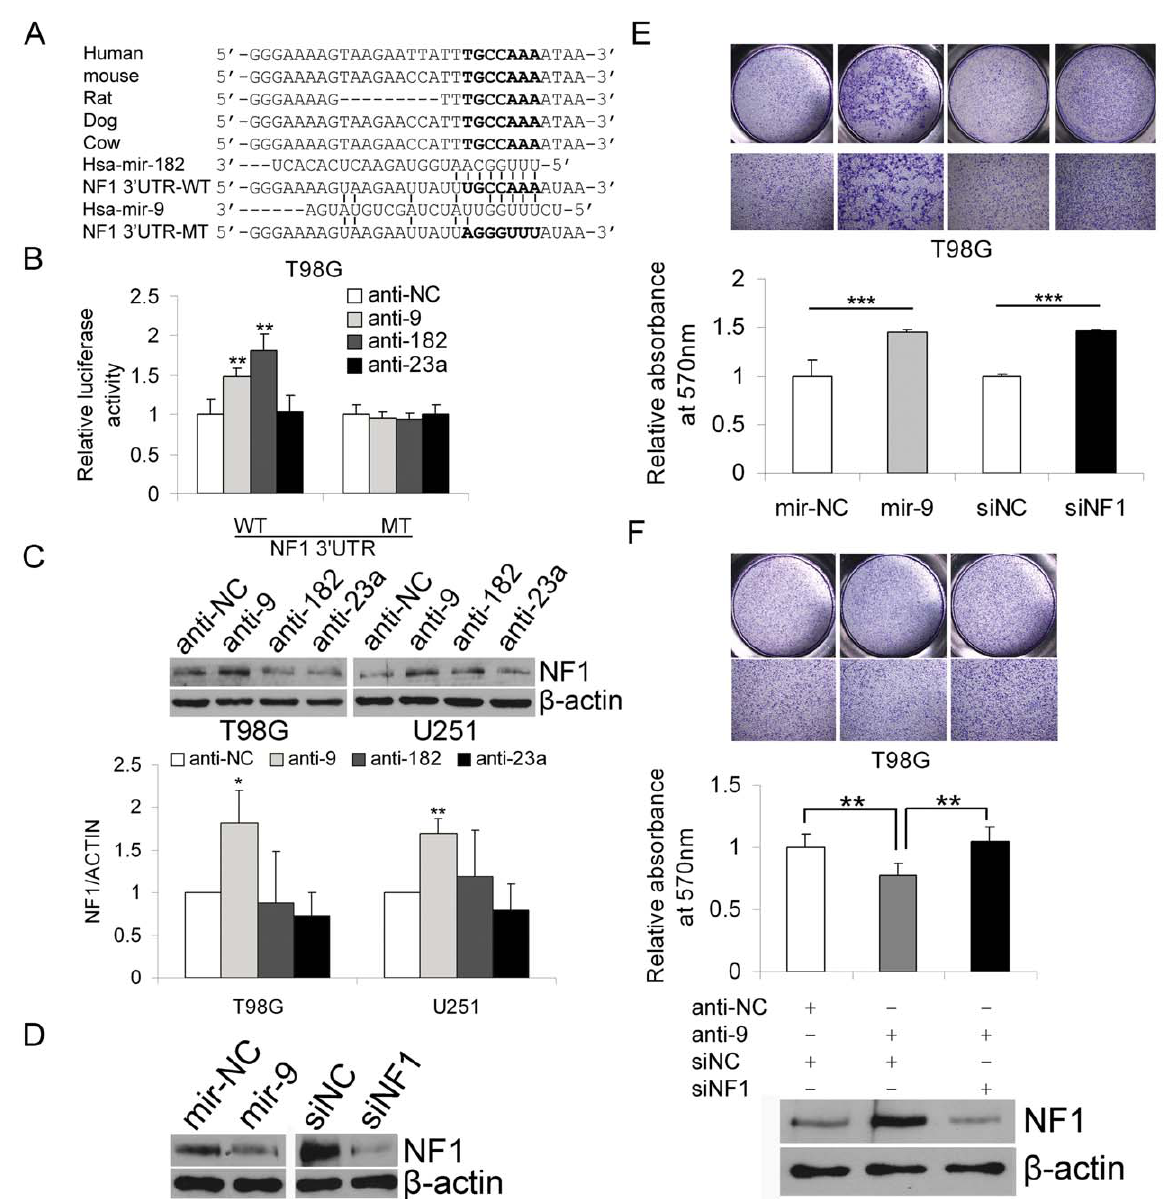
Figure 4. MiR-9 promotes migration through targeting NF1. (A) The NF1 3 9 UTR contains a putative miR-182 binding site which also has the potential to interact with miR-9. The mammalian alignment is shown on the top. A mutated NF1 3 9 UTR was generated by mutating the miR-182 binding site. (B) Luciferase reporter assays were performed to test the interactions between the miRNAs and the NF1 3 9 UTR. NF1 3 9 UTR luciferase reporter constructs were co-transfected with synthetic miRNA mimics (miR-9, miR-182 and miR-23a) or control mimics (miR-NC), and 24 h later the normalized luciferase activity was determined. Data are represented as the mean 6 SD, n=4. (C) MiR-9, miR-182 and miR-23a were knocked-down in T98G and U251 cells by transfection with miRNA antagomirs, and NF1 protein level was determined by western blotting and quantified by densitometric measurement (mean 6 SD, n=3). (D) T98G cells were transfected with miR-9 mimics (or control mimics, miR-NC) or siRNA targeting NF1 (or control non-specific siRNA), and whole cell protein was extracted for determination of NF1 protein levels by western blotting. (E) Over- expression of miR-9 or knockdown of NF1 enhances the migration of T98G cells in a transwell migration assay. Representative photographs are shown on the top. Crystal violet staining was removed and quantified by absorbance measurement (OD570-630) (mean 6 SD, n=4). (F) NF1 knockdown abolished the effect of decreased miR-9 on the migration of T98G cells. Crystal violet staining was removed and quantified by absorbance measurement (OD570-630) (mean 6 SD, n=4). **, P , 0.01, ***, P , 0.001, two-tailed unpaired Student’s t test. On the bottom is a representative western blot result showing that knocking down miR-9 increased the NF1 protein level, whereas simultaneous transfection of siNF1 abolished the increased NF1 protein level. doi:10.1371/journal.pone.0049570.g004 expression levels of miR-9-1and mature miR-9 in T98G and U251 mutation of CRE-a abolished the enhancive effect of CREB (Fig. 6D). For further confirmation of the regulation of miR-9-1 by cells. Indeed, we found significant decreases in the levels of both CREB, we analyzed the effect of knocking down CREB on the pri-miR-9-1 and mature miR-9 (Fig. 6E), suggesting that CREB